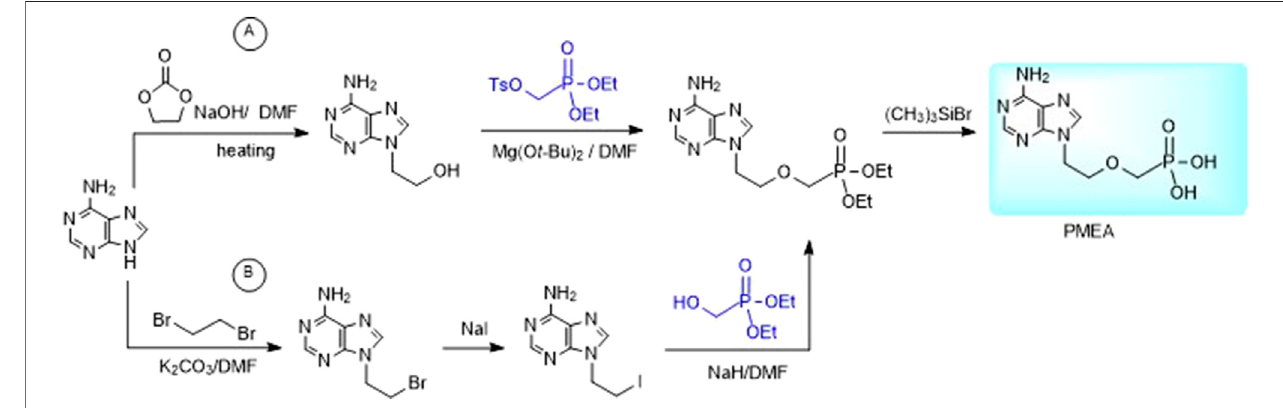
FIGURE 4 | Alternative syntheses of PMEA.